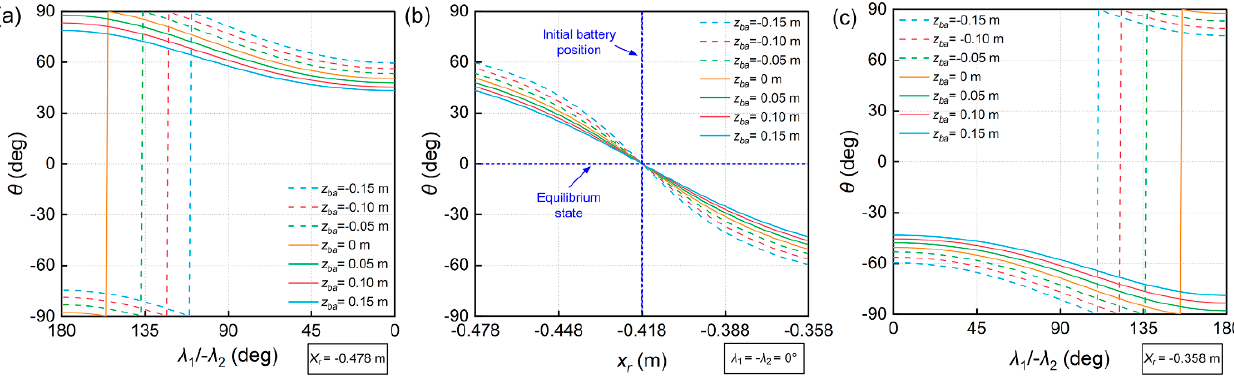
Figure 16. The regulation range of θ for different z ba with m ba equals to 2.0 kg: ( a ) θ vs. λ 1 / − λ 2 ( x r = − 0.478 m); ( b ) θ vs. x r ( λ 1 / − λ 2 = 0°); ( c ) θ vs. λ 1 / − λ 2 ( x r = − 0.358 m).